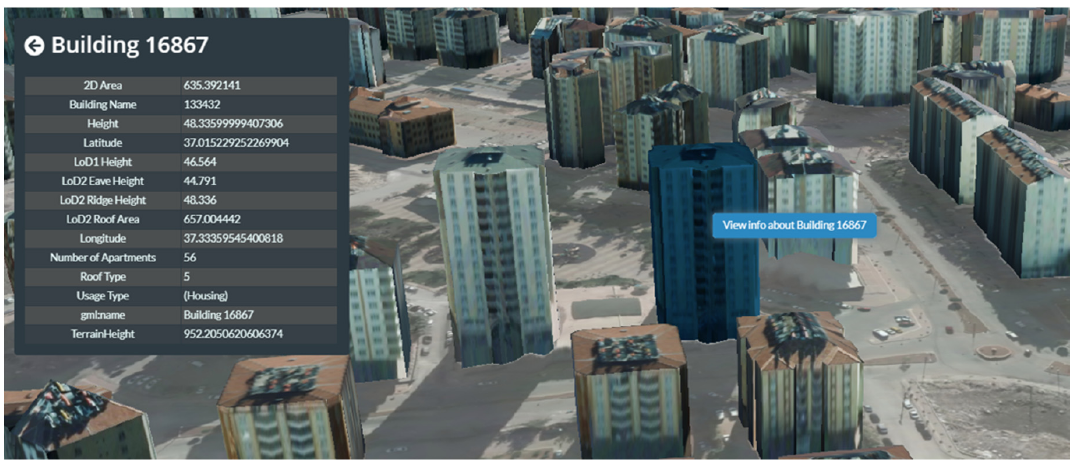
Figure 19. Displaying selected LoD2 buildings attribute table on the customized web interface.